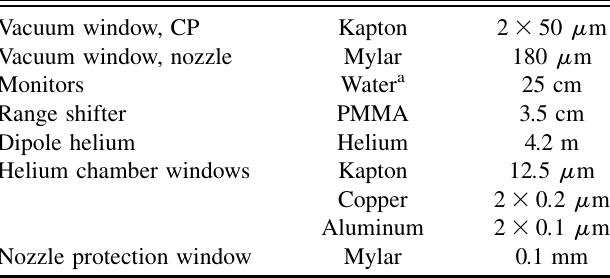
TABLE I. Material and dimensions of scattering material along the beam